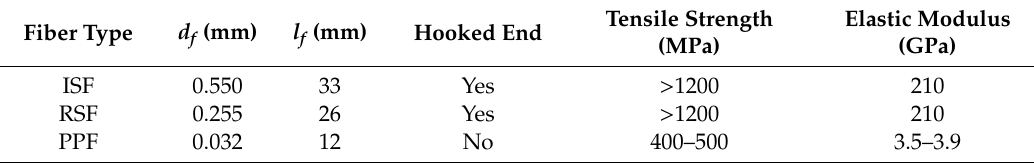
Table 1. Geometrical and mechanical properties of the short